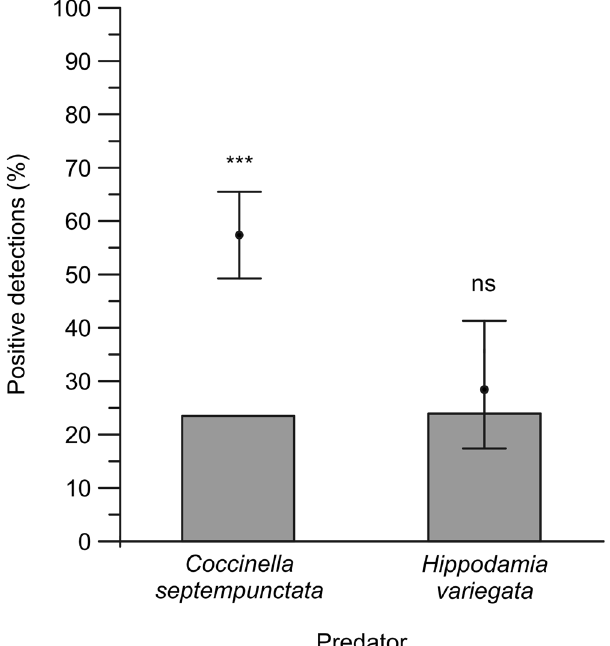
Figure 2. Percentage of C . septempunctata and H . variegata 3 rd and 4 th instars revealed positive for IGP (grey bars) compared with expected predation levels (black dots) and 95% confidence intervals (vertical bars). Comparisons of observed vs. expected predation levels are indicated ( *** : P < 0.001, ns : P >